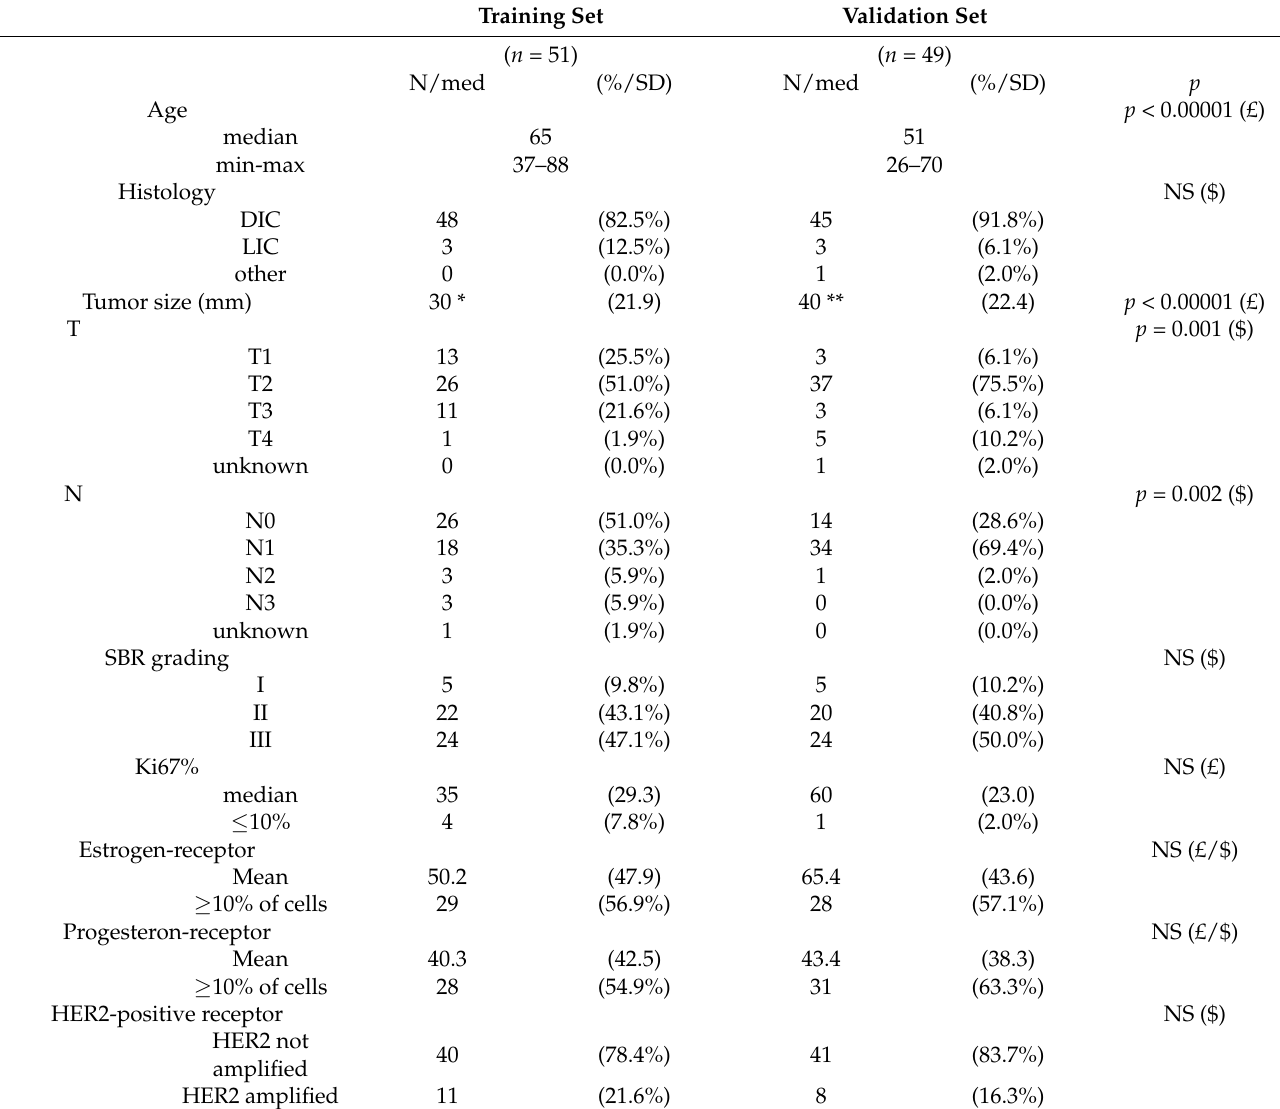
Table 1. Clinical and tumor characteristics (training set and validation set). Training